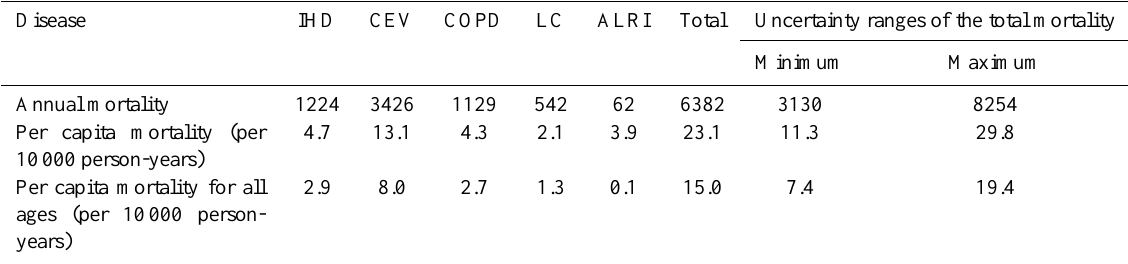
Table 1. Annual mortality attributable to air pollution by disease category and the corresponding per capita mortality (IHD, CEV, COPD, and LC for people > 30years and ALRI for infants < 5years) in 2010–2012 in the Beijing central area, as well as the uncertainty ranges of the total mortality